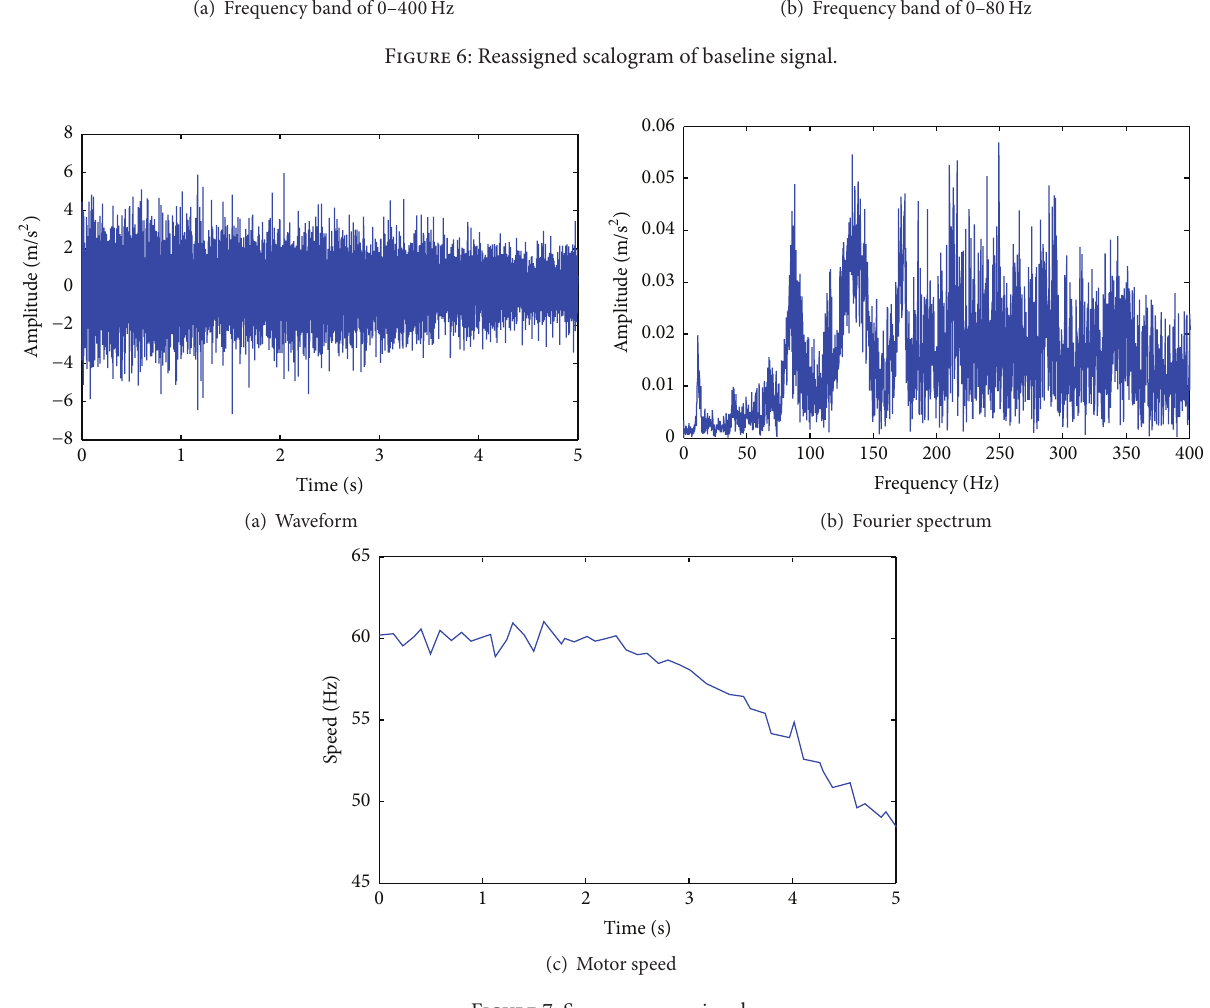
Figure 7: Sun gear wear